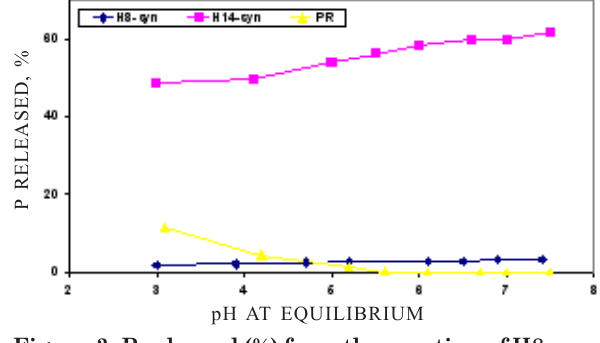
Figure 3. P released (%) from the reaction of H8-syn, H14-syn and Catalão PR as a function of the pH at equilibrium of a 0.01 mol L -1 NaCl solution.